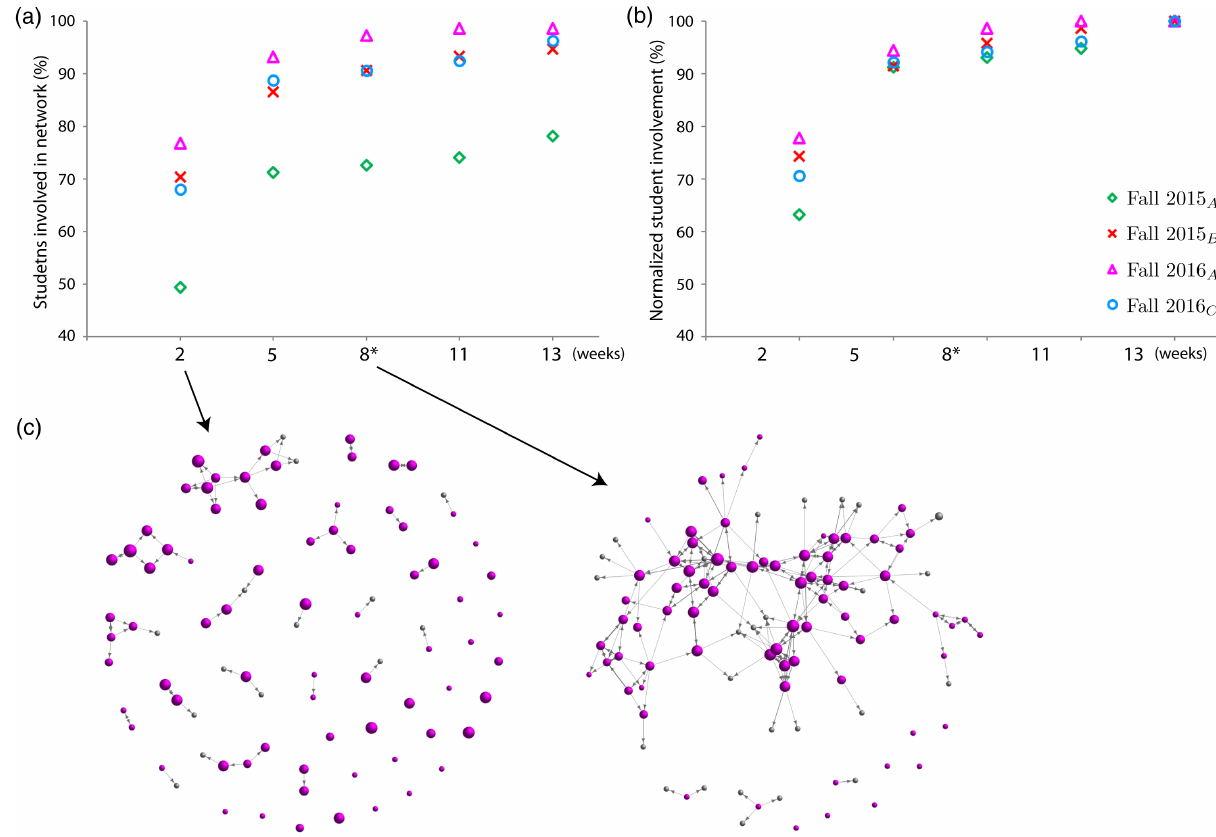
FIG. 2. Changes in out-of-class network involvement for each section as a function of time. (a) Student involvement in the network versus week (for each of the sections). Student involvement is taken as the percentage of students enrolled in the course who either listed other students or were listed by peers on the out-of-class part of the SNA survey. In three out of four sections, over 90 % of students are in the network by week 8 (for the Fall 2015 section, the values are consistently lower by about 20 %). Note that the third collection was A administered in week 8 in three out of the four groups (i.e., Fall 2015 , Fall 2015 , Fall 2016 ) and at the beginning of week 9 in one A B A group (i.e., Fall 2016 ). (b) When normalized by the size of the network at week 13, it becomes clear that the network evolution is C comparable between sections and that the equilibrium is basically reached by midsemester (week 8, the third collection). (c) An example of the out of class network at week 2 and 8 for section Fall 2015 (see Fig. S1 in the Supplemental Material [20] for the other sections). B At week 2, only a few connections are present. By week 8, however, a strong network of students exists, with only a handful of students not embedded within the network. The size of the nodes in both networks corresponds to closeness at week 8 and the color indicates whether a node is a student (magenta) or a person that was not enrolled in the course